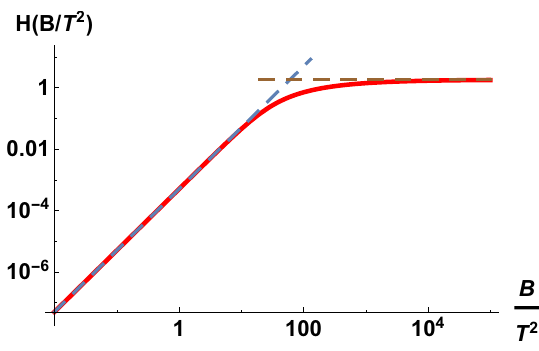
Figure 1 . Temperature dependence of H in (3.15) as a function of the dimensionless parameter B=T 2 . H interpolates between a power-law (cid:24) ( B=T 2 ) 2 at high temperatures B=T 2 (cid:28) 1 and a constant at low temperatures B=T 2 (cid:29) 1. Dashed lines show the asymptotic